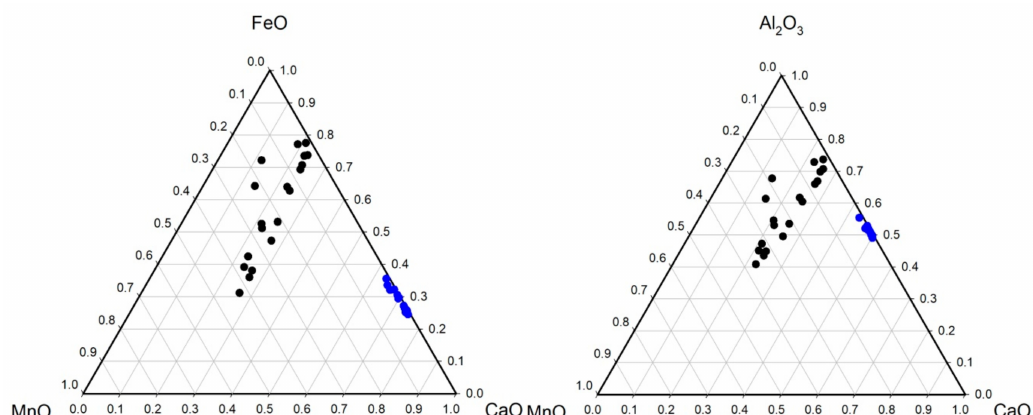
Figure 10. Ternary plots of the composition of the normalized major element oxides of garnet (excluding Si and O). The blue squares and black circles are used to distinguish the same two groups across the two plots.